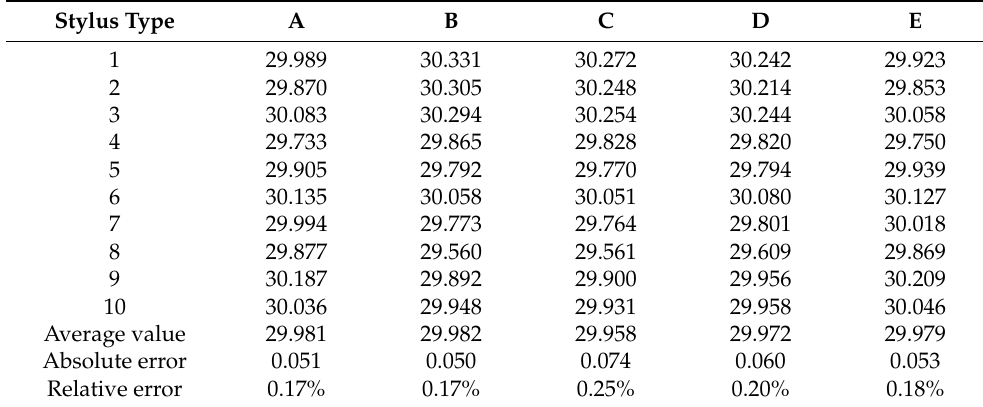
Table 1. Self-calibration